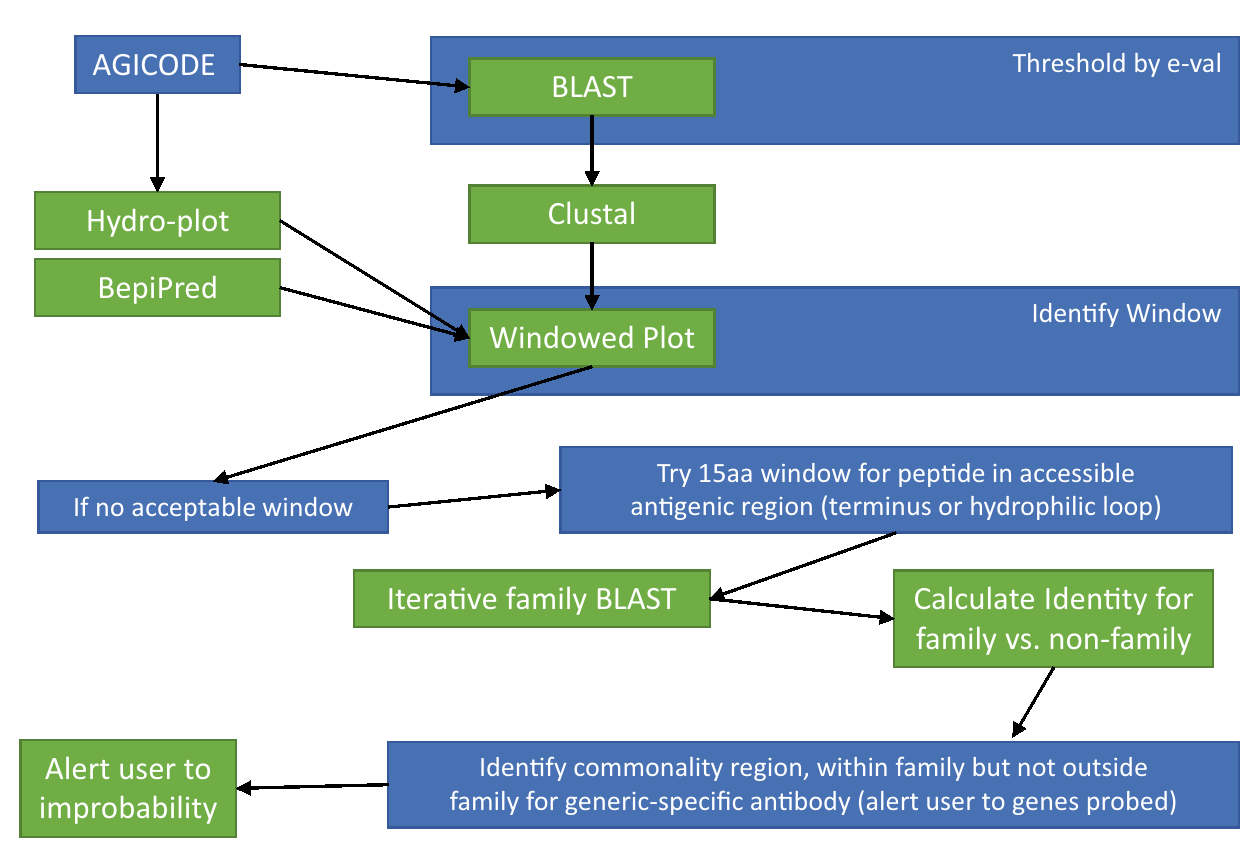
Figure 3. Bioinformatics approach used for identification of protein segments used for antibody